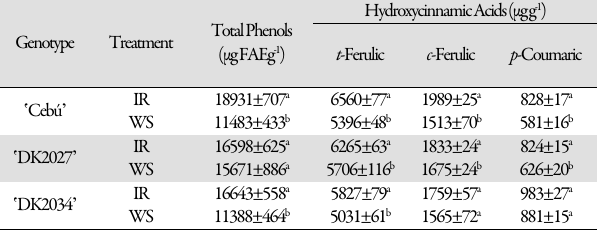
Table 2. Effect of water stress on the total phenols and hydroxycinnamic acids in the studied maize hybrids Genotype